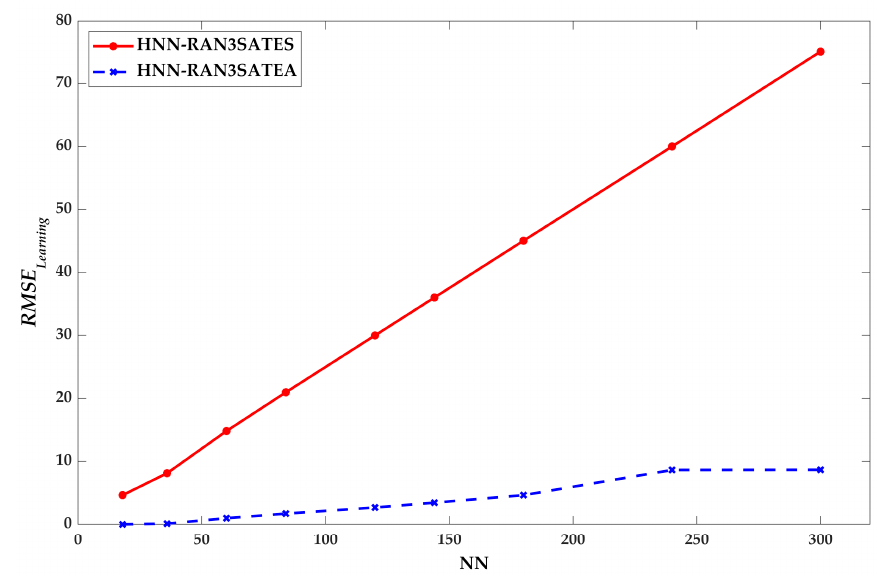
Figure 3. Learning RMSE for HNN-RAN3SAT model.